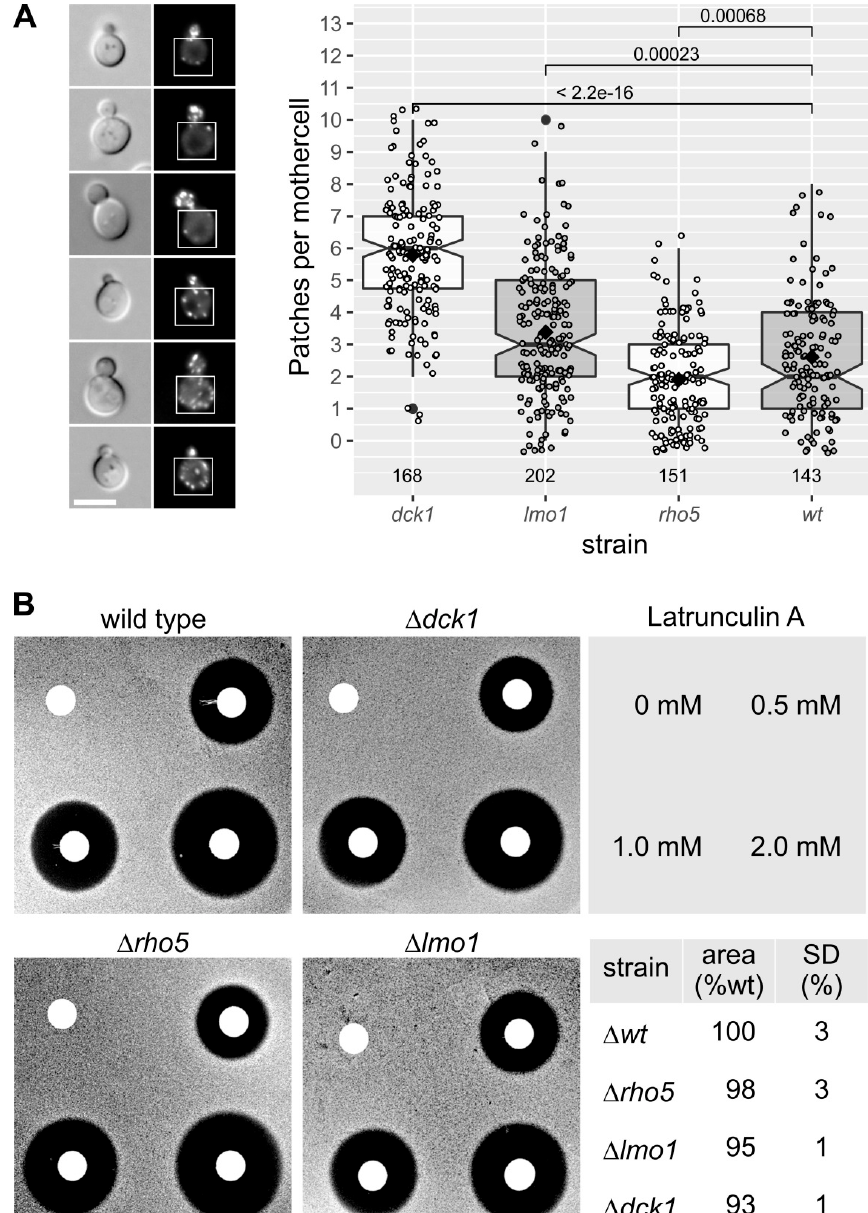
Figure 6. Deletion of DCK1 moderately affects the actin cytoskeleton. ( A ) Life-cell fluorescence microscopy of strains carrying a genomic CAP2-GFP fusion in combination with the different gene deletions indicated and statistical analysis of actin patch numbers in mother cells. Exemplary images of cells with different numbers of actin patches in the mother cell are shown at the left. The scale bar is 5 µm. ( B ) Halo assay for Latrunculin A sensitivity. Further details on the interpretation of the box plot and the halo assay can be found in Materials and Methods.